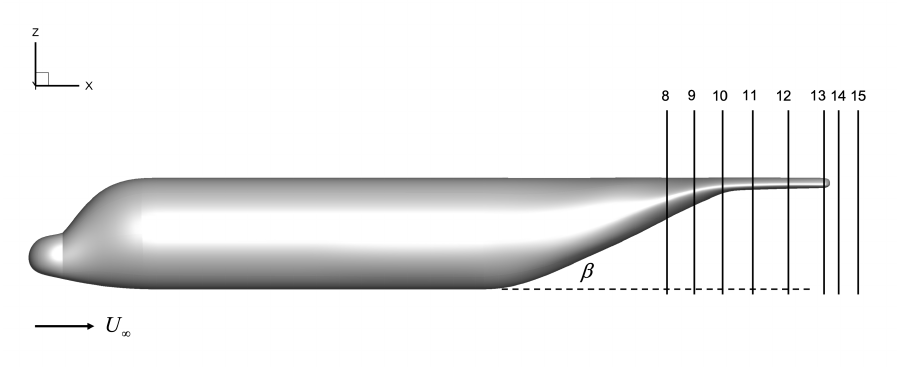
Figure 17. Slice position for monitoring the vorticity of military